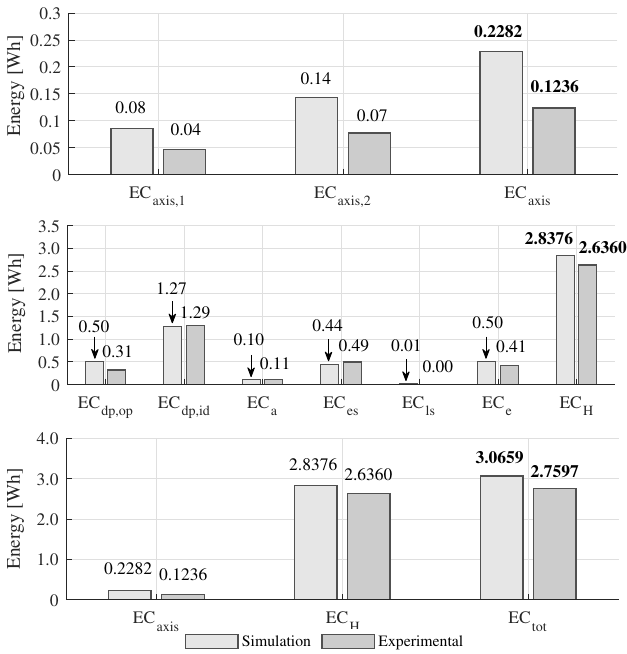
Figure 11. Bar graph of Energy Consumption analysis, including the simulation and experimental